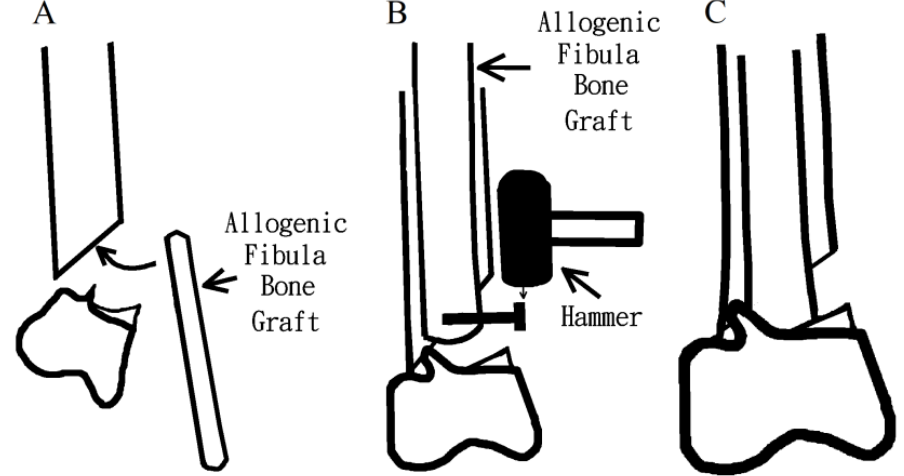
Figure 2. Line drawings depicting the method for insertion of the allograft. ( A ) The fibula bone graft was inserted; ( B ) A temporary screw was inserted at the distal part of the bone graft, and pulled the bone graft to the appropriate position; ( C ) The bone graft placement to the accurate position was accomplished, and prepared for plate fixation.